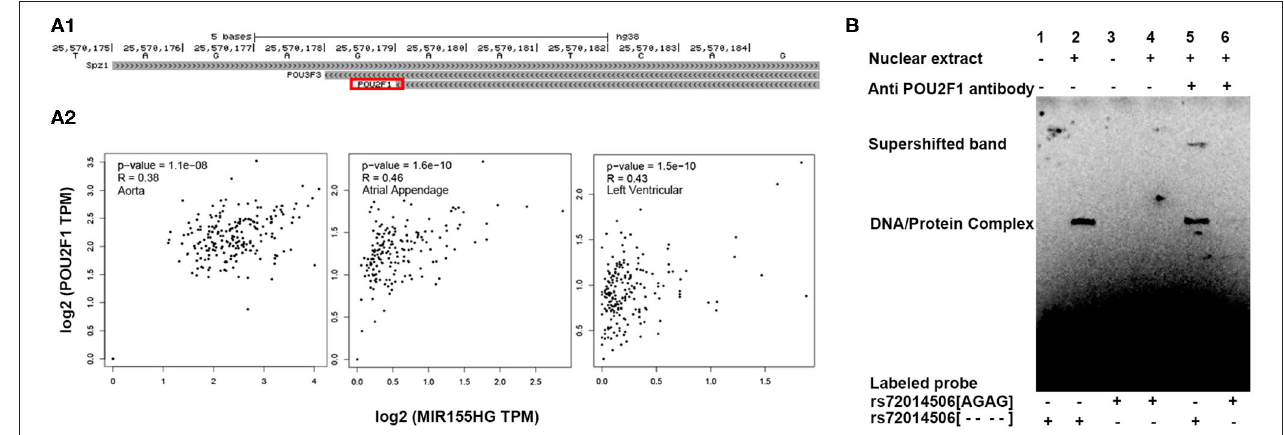
FIGURE 5 | POU2F1 mediated the interaction of rs72014506 with MIR155HG expression. (A) Transcription factor prediction and correlation analysis results. (A1) This UCSC Genome Browser track hub represents genome-wide predicted binding sites for transcription factor binding profiles in the JASPAR database CORE collection; this view only showed predicted binding sites with scores above 350, which indicated that the P -value of the TF match to indel position was < 0.001. The same TFs in TFBIND prediction result were highlighted by a red square. (A2) The expression of POU2F1 and MIR155HG presents a significant correlation in human aorta, atrial appendage, and left ventricular tissues. (B) Electrophoretic mobility shift assays with biotin-labeled DNA sequence containing the rs72014506[AGAG] or rs72014506 [- - - -] and nuclear extracts from 293T cells. Lanes 1 and 3 show mobility of the labeled oligonucleotides without nuclear extracts; lanes 2 and 4 show mobility of the labeled oligonucleotides with nuclear extracts. A DNA–protein complex was presented when [- - - -]-containing DNA was incubated with nuclear extracts (lane 2) but not [AGAG]-containing probe (Lane 4). In super-shift EMSA, the super-shifted band only appeared when anti-POU2F1 antibody was incubated with rs72014506[- - - -]-labeled probe (Lane